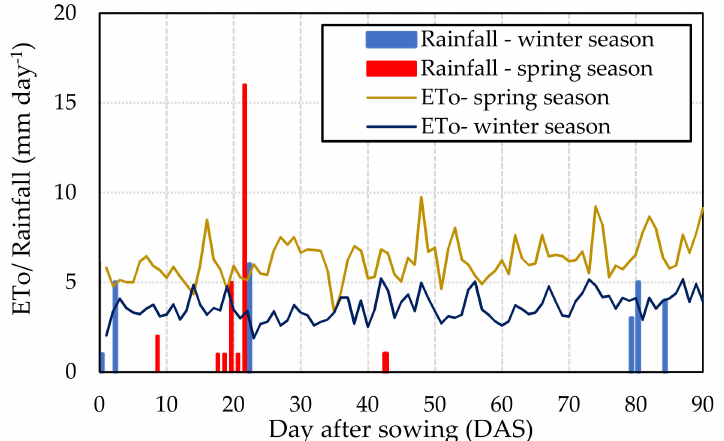
Figure 2. Seasonal reference evapotranspiration (ETo) at the experimental field throughout the winter and spring growing seasons.